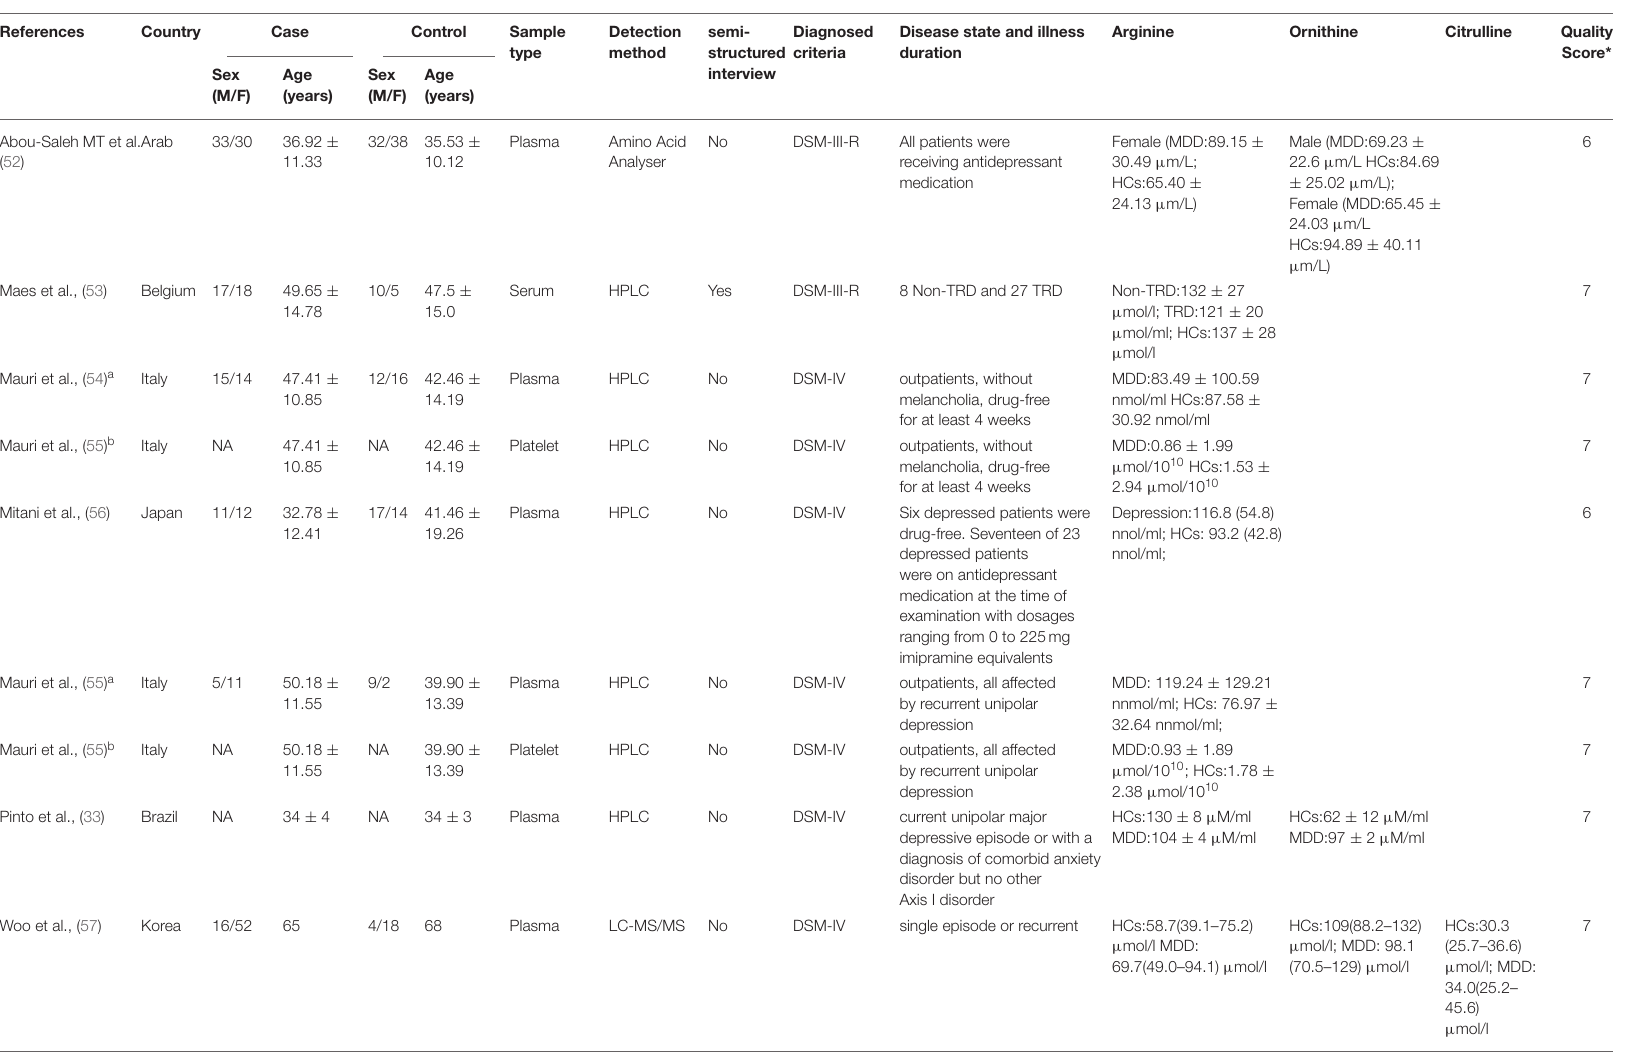
TABLE 1 | Characteristics of the included studies in the